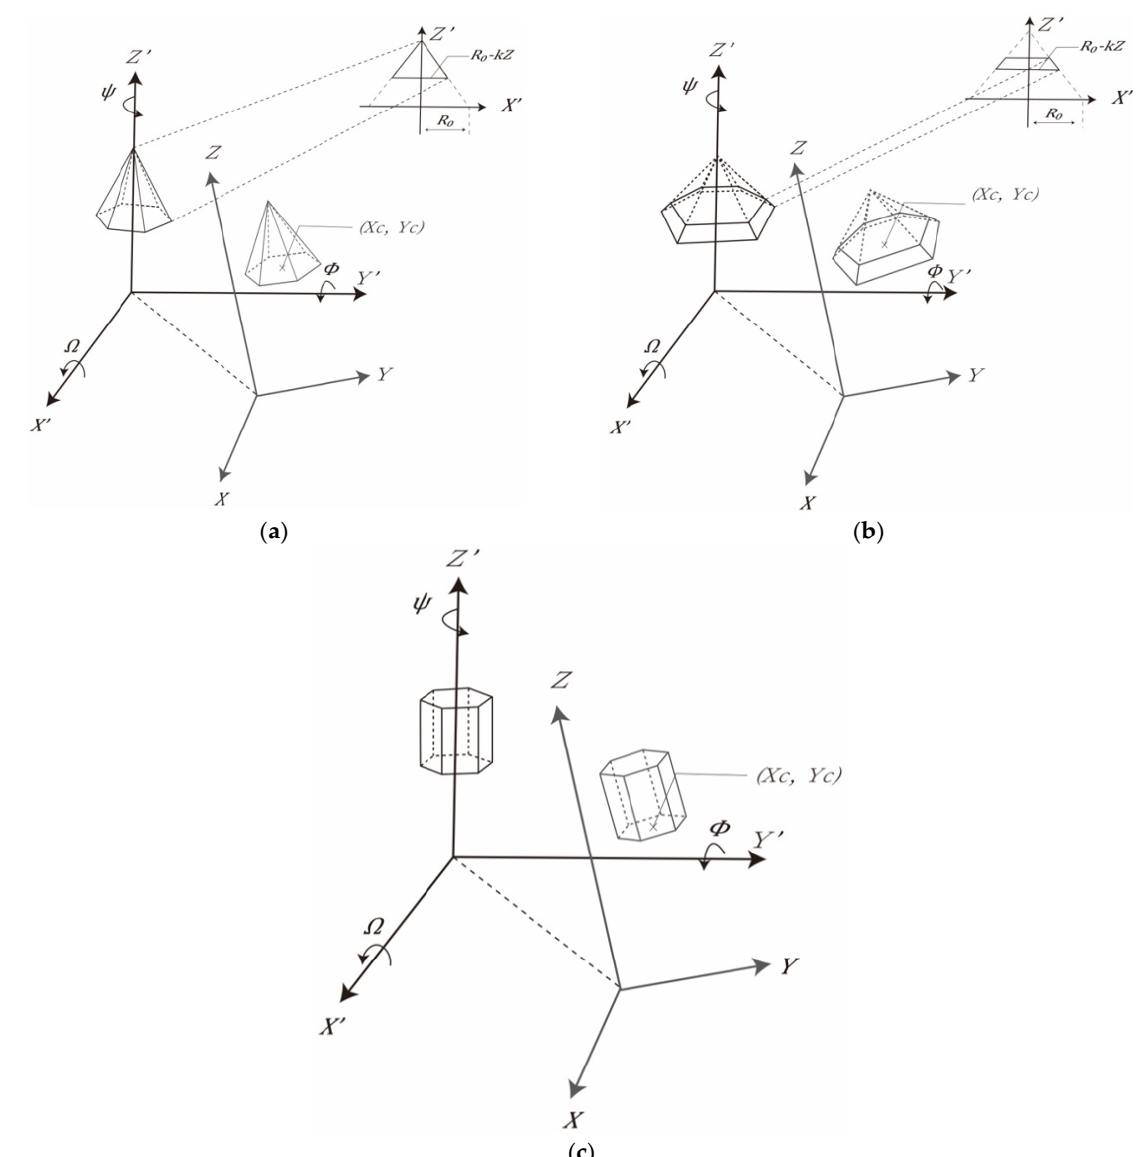
Figure 3. Model parameters of the main components of hexagonal pagoda: ( a ) a roof; ( b ) an eave; and ( c ) a main body (floor).